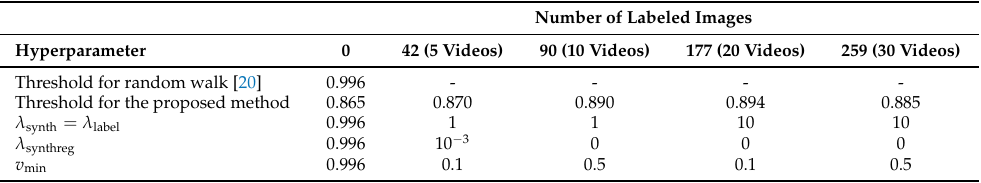
Table A1. Hyperparameters selected in the experiments by the grid search.